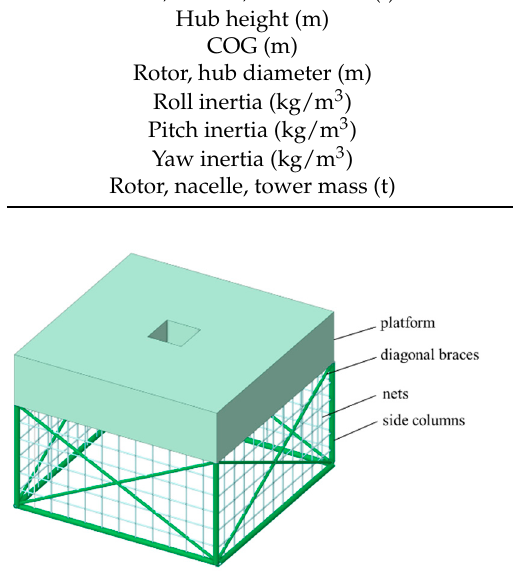
Figure 5. Details of the aquaculture cage. Table 2. Specifications of the NREL 5 MW wind turbine. Table 1. Main parameters of the barge-type platform.